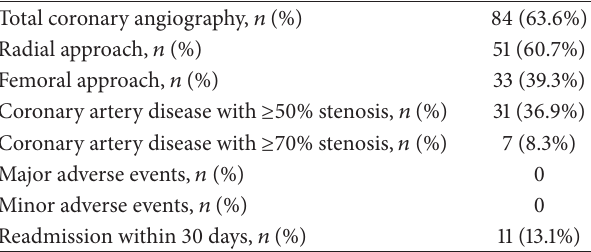
Table 2: Characteristics of coronary